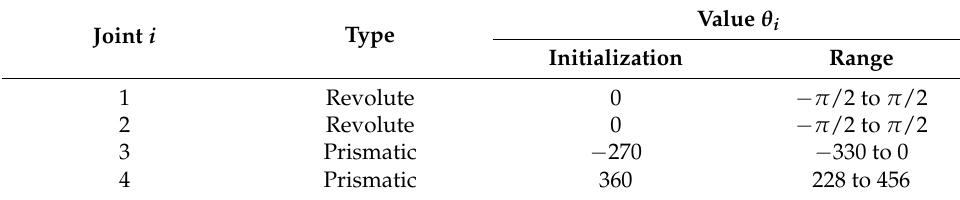
Table 1. Joint type and its value range.